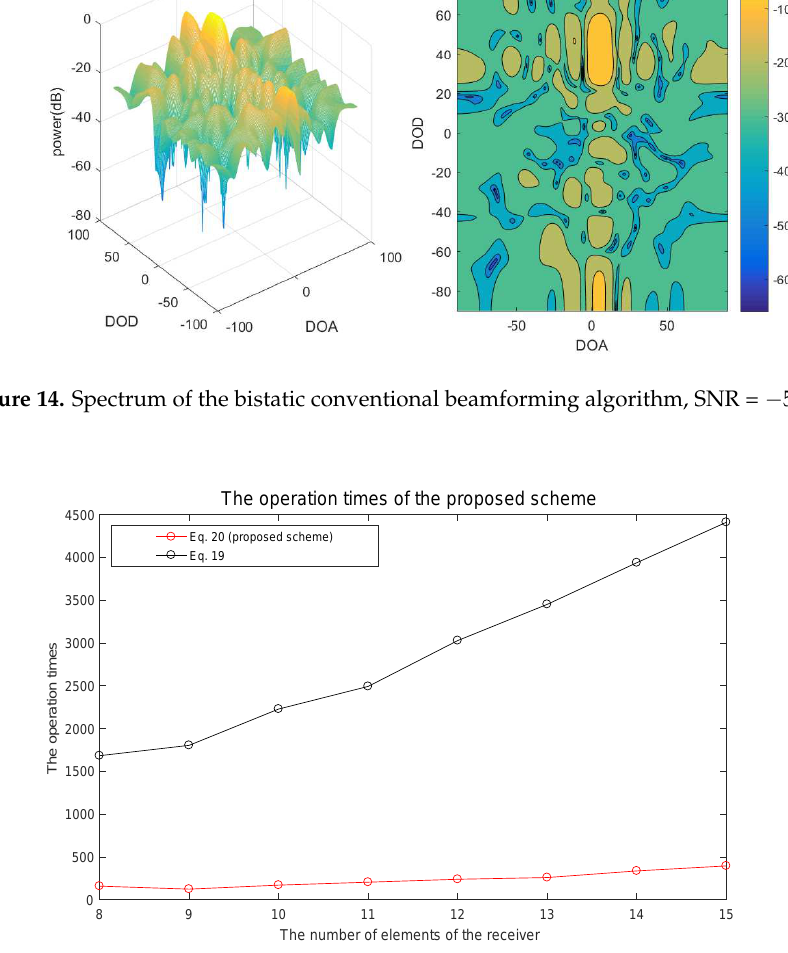
Figure 15. The operation times Comparison between the proposed scheme using the parameter ( β 2 ) of the constraint condition and the other scheme without using the constraint